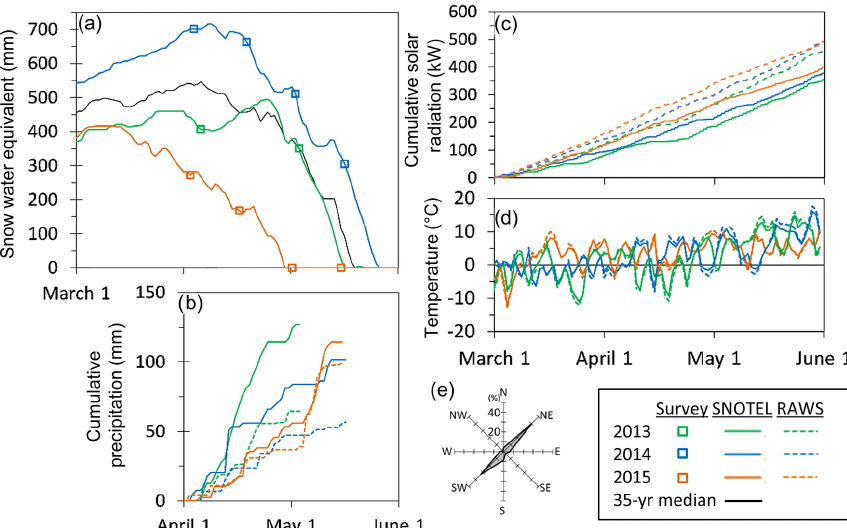
Figure 2. (a) Daily snow water equivalent (SWE) measured at the SNOTEL station each spring of the study period and the 35-year median of the station measurements, (b) cumulative precipitation occurring during the spring survey study periods of April and May as measured at the SNOTEL and RAWS site, (c) cumulative solar radiation at the SNOTEL and RAWS sites during spring, (d) mean daily temperature at the SNOTEL and RAWS sites during spring, and (e) wind rose of spring data for the three years studied at the SNOTEL